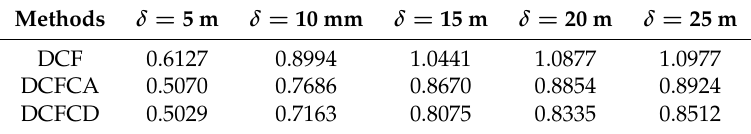
Table 4. Velocity ARMSE of different measurement noise